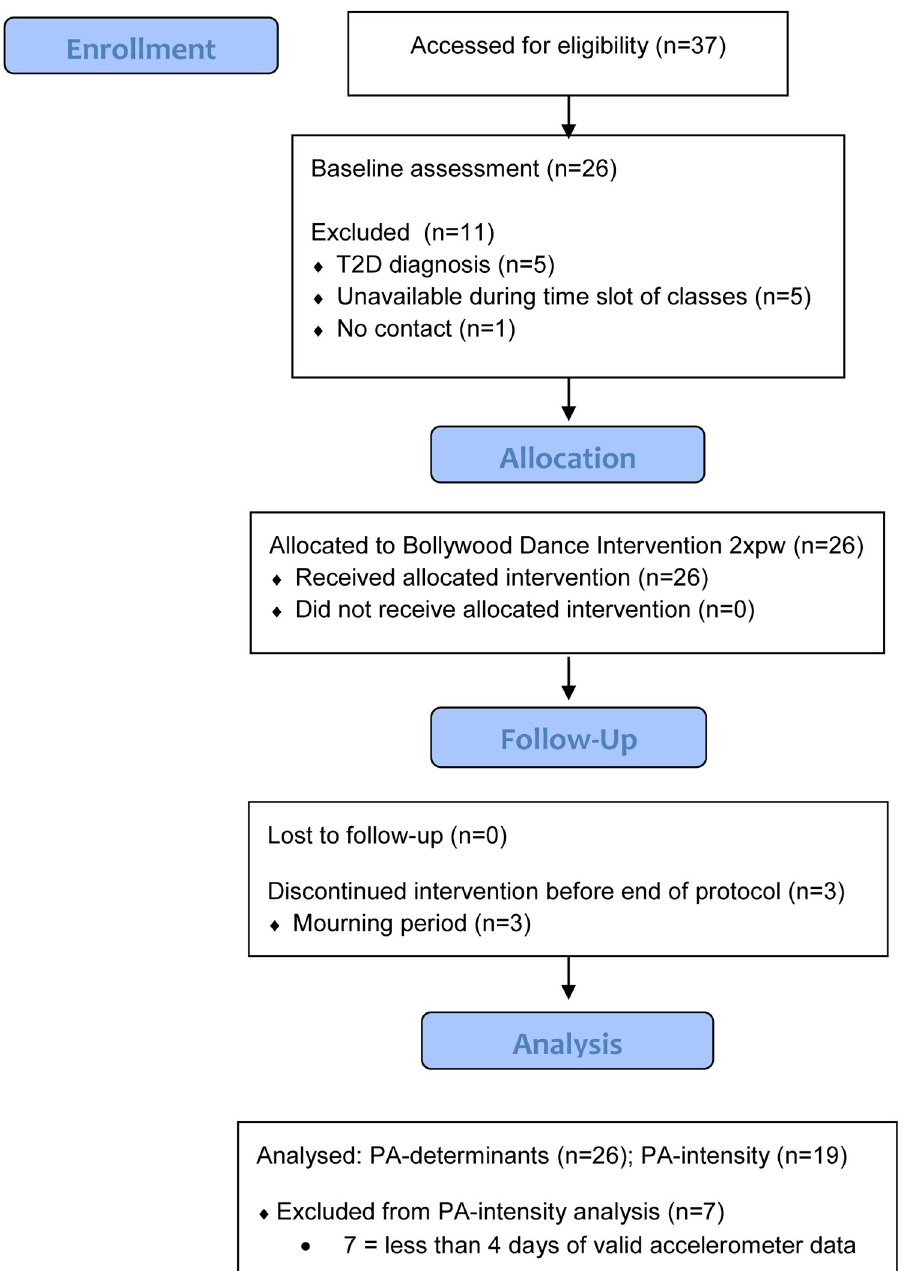
Fig 1. Flow diagram of the